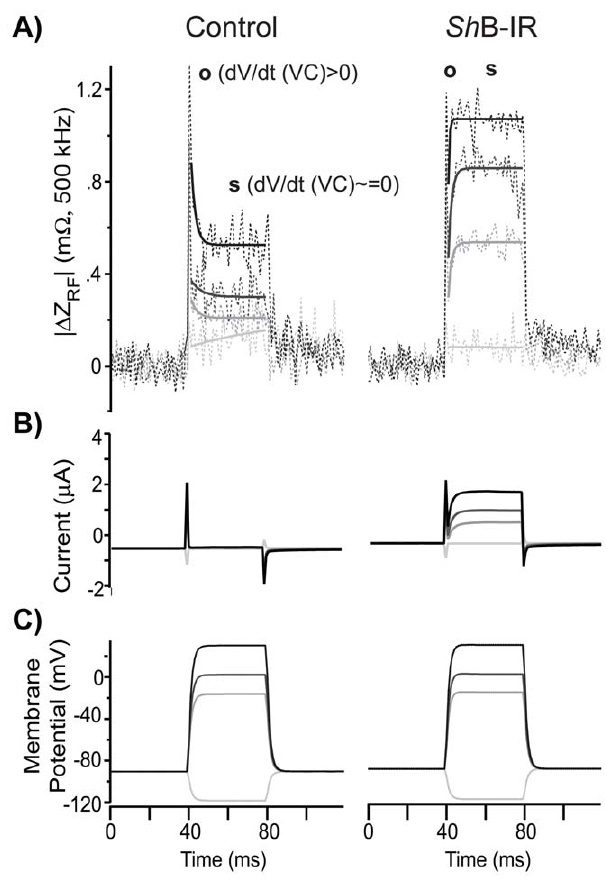
Figure 2. Temporally Resolved RF Measurements. A) RF impedance changes (| D Z RF |) measured during TEVC relative to the impedance at holding potential ( 2 90 mV) in control oocytes, express- ing endogenous proteins only ( n =10, left column), and Sh B-IR expressing oocytes ( n =9, right column). Sh B-IR expressing oocytes elicited a membrane-potential-dependent (V m* ) RF response different than control oocytes. RF impedance changes were analyzed in two regions; the RF response during the onset of voltage-step ( o , average | D Z RF | o 0–1 ms after voltage step, dV m* /dt . 0) and the RF response after membrane potential achieved its command (steady-state) level ( s